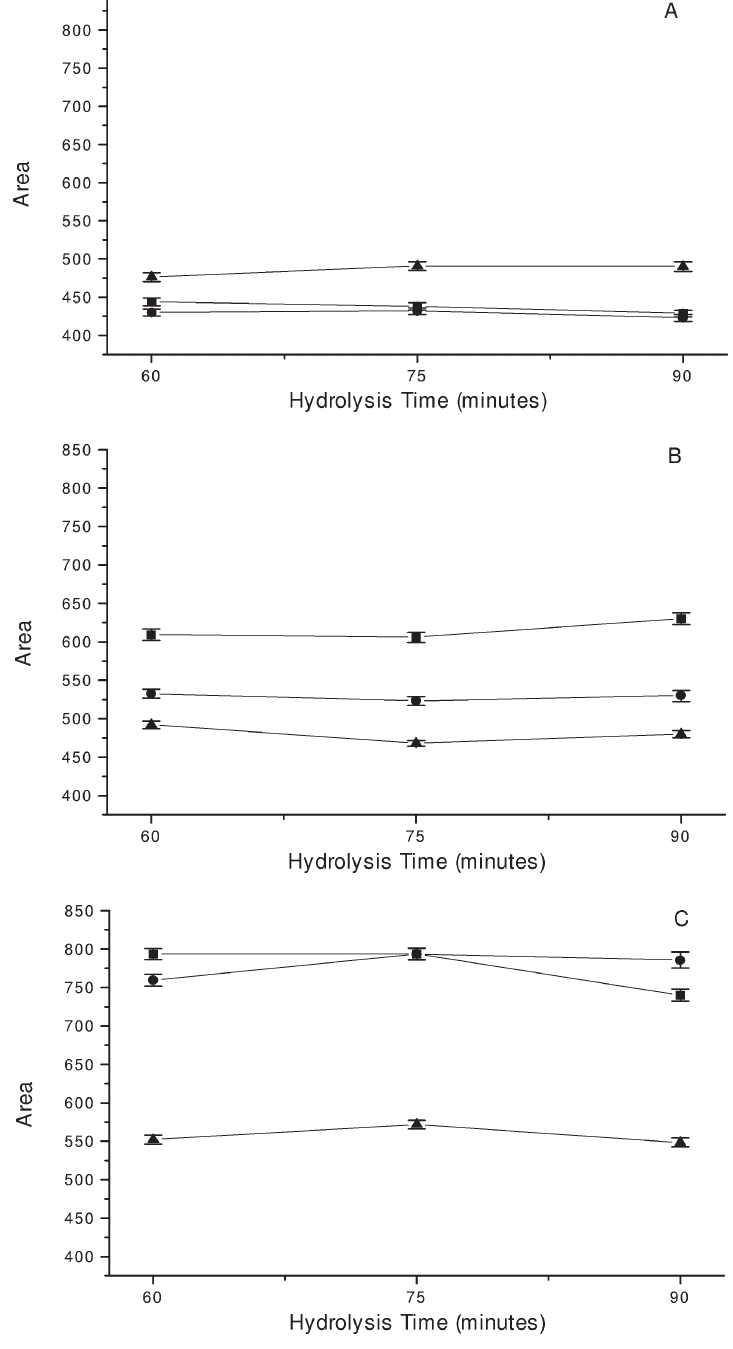
Fig. 2. Mean values ( (cid:6) SEM) of nuclear area in the plateau range of hydrolysis curve for lymphatic cells (A), epithelial cells from buccal mucosa (B) and uterine myometrial cells (C) fixed by different types of fixatives: (cid:4) – Delaunay, (cid:15) – Saccomanno, N – air-drying with postfixation in modified Böhm–Sprenger